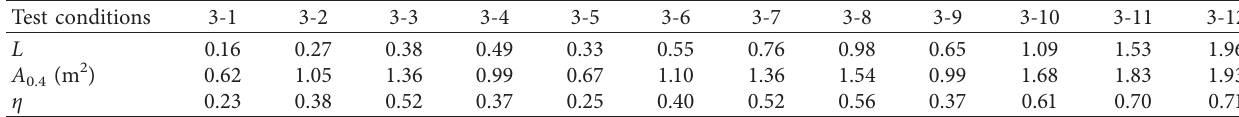
Figure 9: Amplitude reduction ratio contour map for test conditions (a) 3-5, (b) 3-7, and (c) 3-8. Table 9: List of vibration isolation